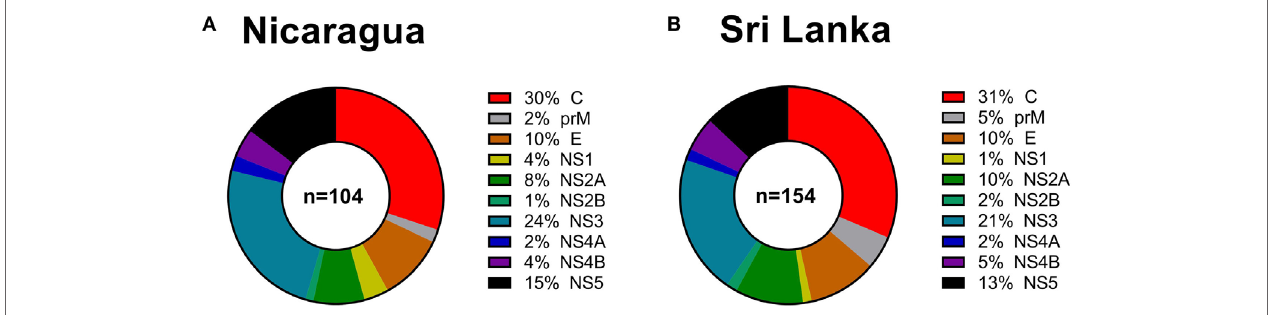
FigUre 2 | Patterns of protein immunodominance of CD4 + T cells responses in Nicaragua and Sri Lanka. Pie charts indicate the percentage of total magnitude of responses per protein observed in 104 Nicaragua (a) and 154 Sri Lanka (B) donors tested using identical methodology. Data from the Sri Lanka donors were published previously (12) and are shown here for reference purposes